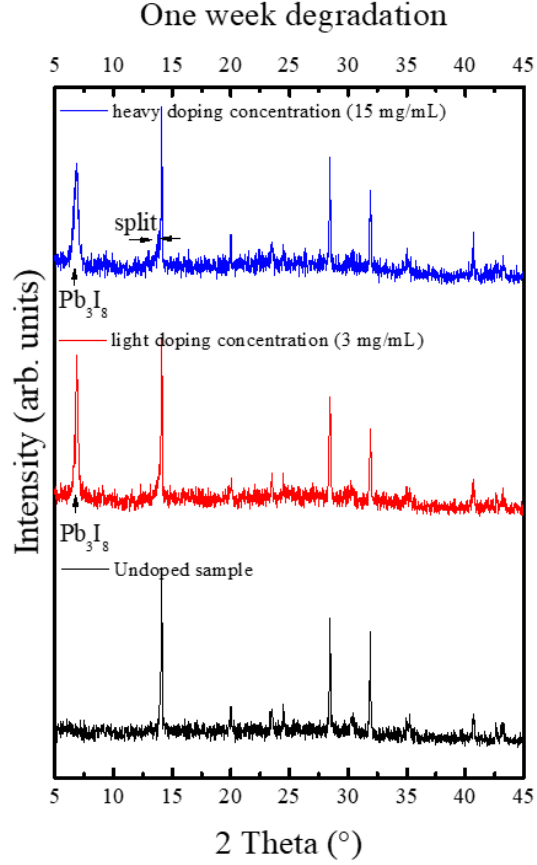
Figure 5. The XRD patterns of PSCs after one-week exposure in air.